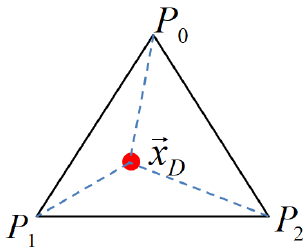
Figure 3. Linear interpolation at the departure point, its value is approximated by the values on three vertexes of the triangle.